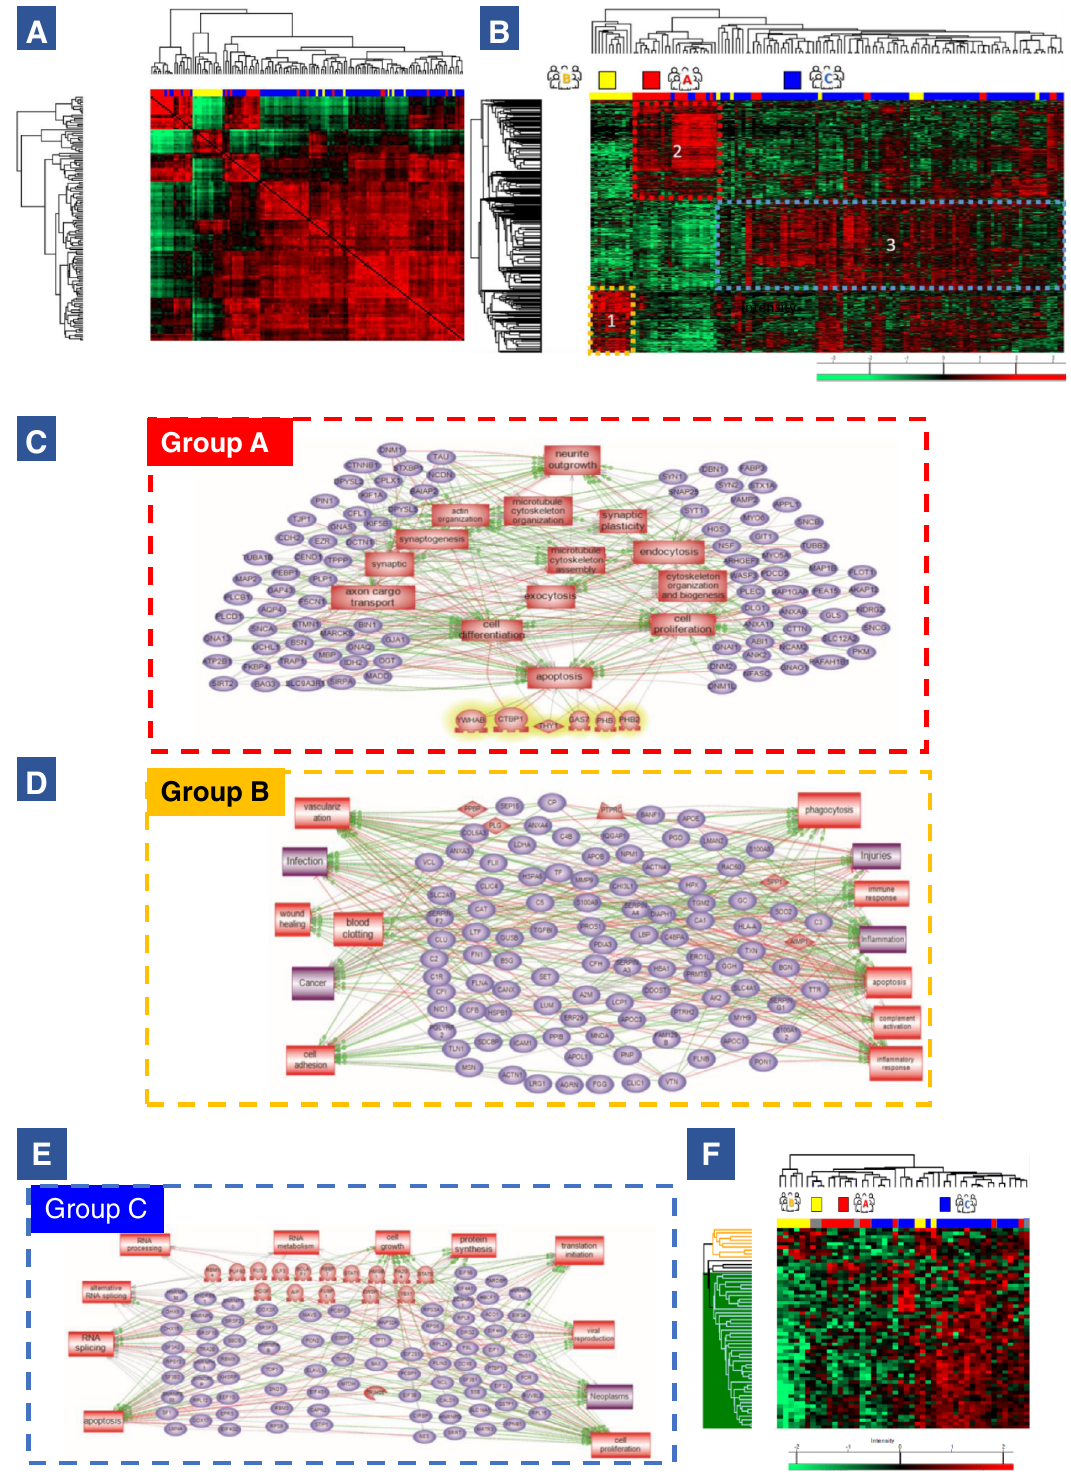
Fig.2|Spatiallyresolvedshotgunproteomicsanalysis.A Matrixcorrelationmap betweenallmicroextractionpointsfromthe46tumors.Correlationcoef fi cientsare calculated between each sample and are represented on a heatmap. B Heatmap of proteins with different regulation pro fi les as determined after label-free quanti fi - cation in the three groups highlighting the presence of three clusters. Shotgun proteomics was performed after on-tissue trypsin digestion followed by micro- extraction at the spots determined from MALDI-MSI data. C Pathway analysis of proteins overexpressed in group A reveals that a large majority of protein is involvedin(a)neurogenesis,braindevelopment,synaptogenesisandcytoskeleton